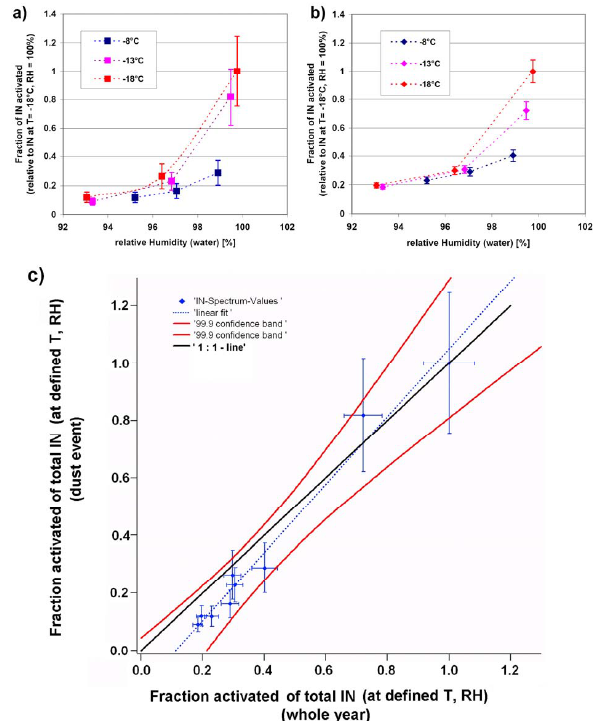
Figure 10: Fig. 10. Panel (a) fractional activation (% of maximum) of IN as function of water saturation during the dust episode. Panel (b) same as in (a) but from 352 samples at the Taunus Observatory during 2008/09. Panel (c) : scatter plot of data from (a) vs. data from (b).